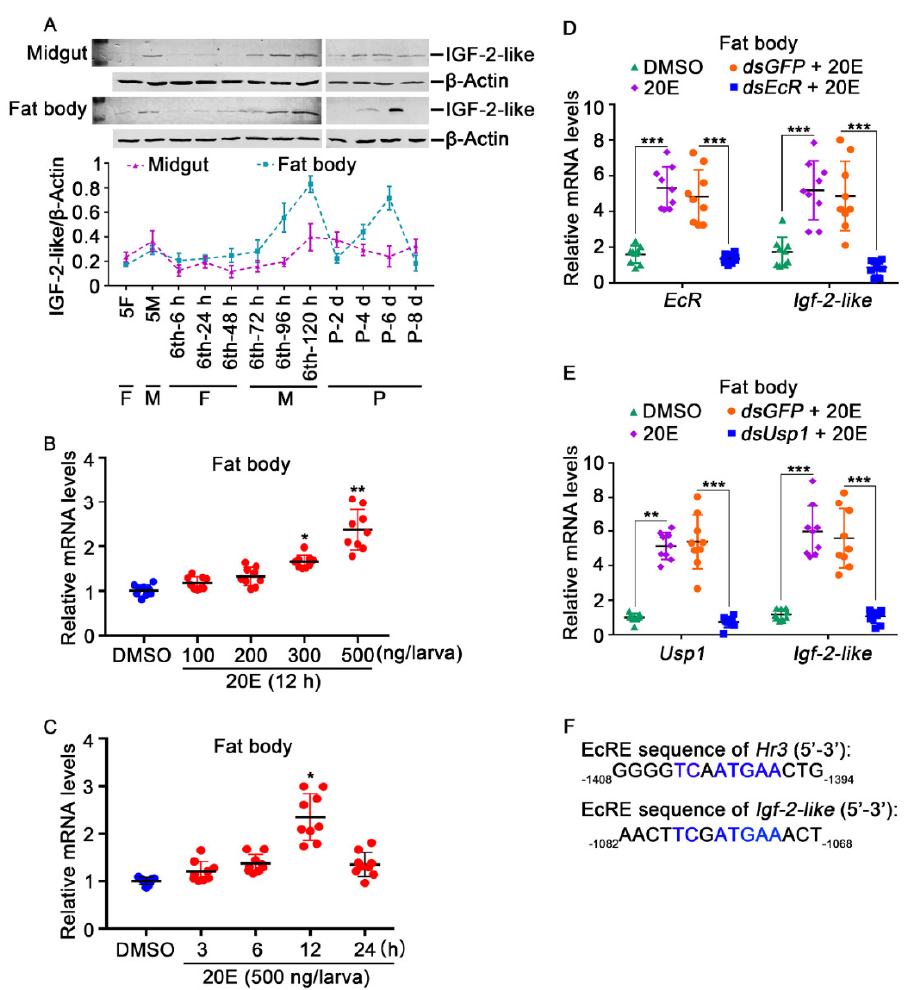
Figure 2. Igf-2-like mRNA expression and 20E stimulation. ( A ) The protein levels of IGF-2-like in the midgut and fat body at different stages. β -ACTB was used as an internal reference protein. The concentration of the gel was 12.5%. Image J was used to calculate the ratio of IGF-2-like and β -ACTB band densities. All the experiments comprised three biological replicates. The error bar indicates the mean ± SD. 5F: the 5th instar feeding stage; 5M: the 5th molting stage; 6th-6 h, 6th-24 h, 6th-48 h, 6th-72 h, 6th-96 h and 6th-120 h correspond to different stages of the 6th instar; P-2 d, P-4 d, P-6 d and P-8 d correspond to different pupal stages. F: feeding stage; M: molting stage; MM: metamorphic molting stage; P: pupal stage. ( B ) The expression of Igf-2-like in the fat body after 12 h of stimulation with various concentrations of 20E. ( C ) Different time gradients were used to detect the regulation of Igf-2-like by 20E (500 ng/larva), and the same amount of DMSO was used as a negative control. Three biological replicates were performed for each experiment, and each biological replicate included three technical replicates, represented by dots. ( D , E ) EcR and Usp1 knockdown in the fat body using dsEcR or dsUsp1 (2 μg/larva), followed by stimulation with 20E (500 ng/larva) for 12 h to detect Igf-2-like expression, qRT-PCR experiments were carried out using three biological and three technical repetitions. The error bar indicates the mean ± SD. Student’s t -test analysis indicates the significant differences (* p < 0.05, ** p < 0.01, *** p < 0.001). ( F ) Alignment of the EcRE in the 5'-upstream region of Hr3 and Igf-2-like .